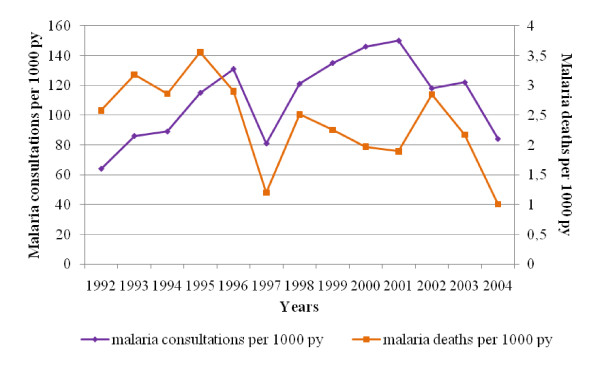
Evolution of consultations for malaria in health care facilities and deaths attributable to malaria in Niakhar area (1992-2004). The purple line represents the clinical malaria morbidity in dispensaries per 1,000 person-year at risk (py). The orange line represents the malaria mortality per 1,000 py in the population.